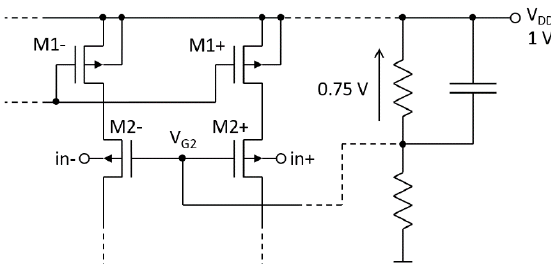
Figure 10. The off-chip generator of V G2 used for tests of the prototype LTA of Figure 3. Figure 10. The o ff -chip generator of V G 2 used for tests of the prototype LTA of Figure